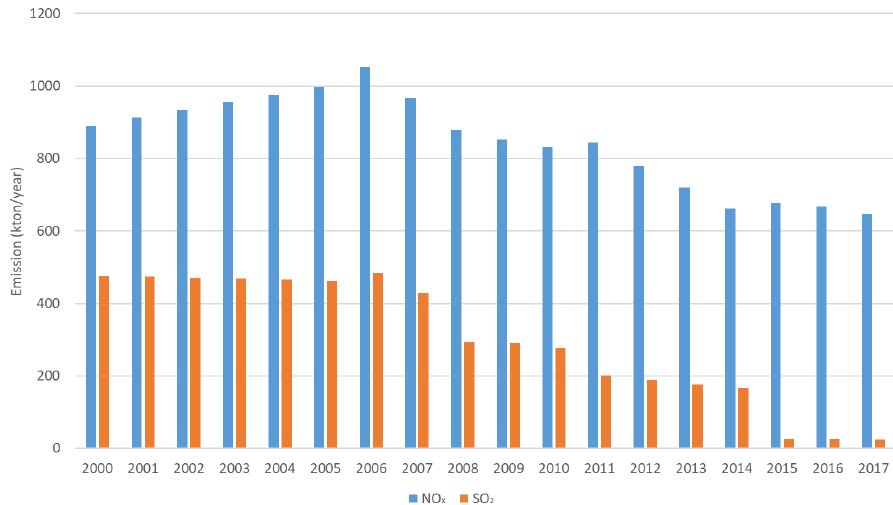
Figure 7. Emissions of NO x and SO 2 for the North Sea (NOS) including the English Channel (ENC) over 2000–2017. Table 3. Relative change between CAMS-REG-v4.2 and its predecessors (TNO_MACC-III and CAMS-REG-v2.2.1) for each pollutant for selected years for the EU + as a